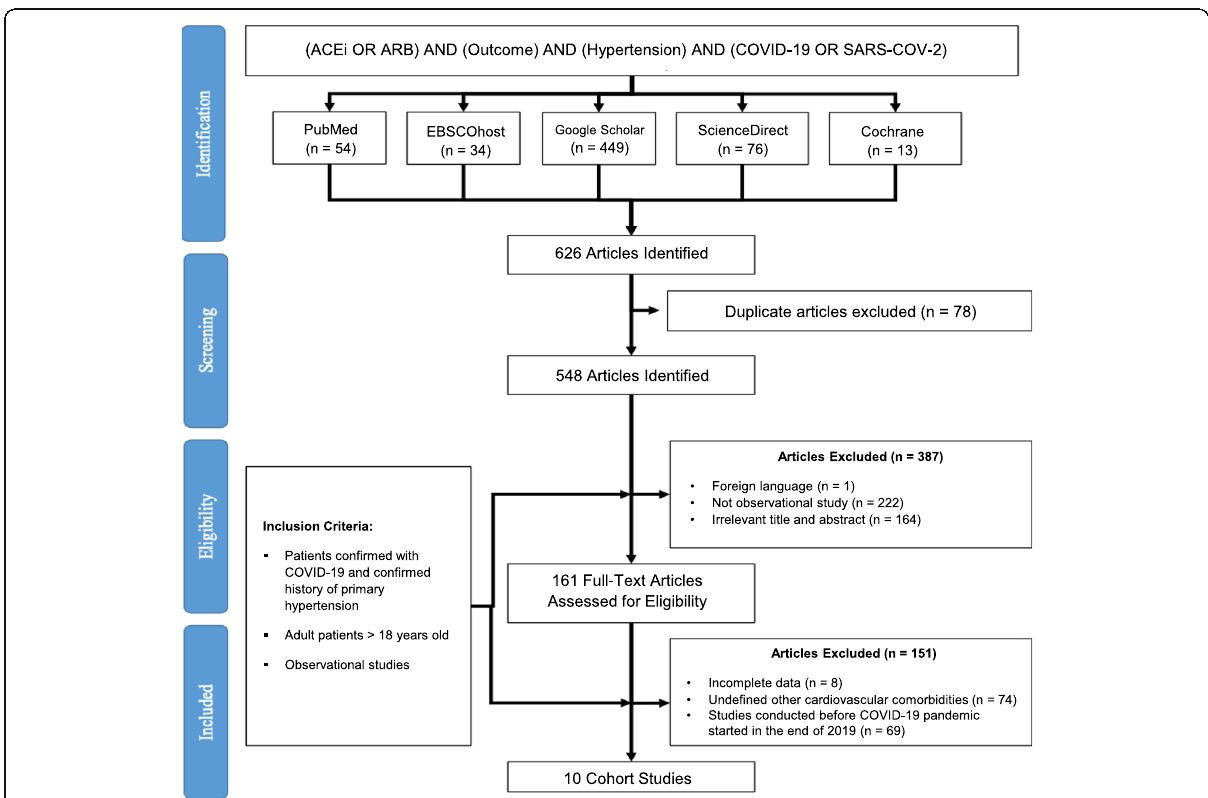
Fig. 1 Schematic search strategy results in the standardized PRISMA flow